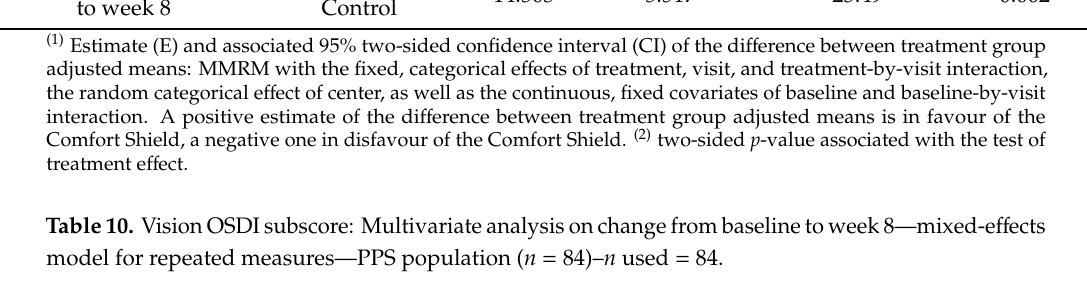
Table 9. Pain OSDI subscore: multivariate analysis on change from baseline to week 8—mixed-e ff ects model for repeated measures—PPS population ( n = 84)— n used = 84. Parameter Comfort Shield vs.